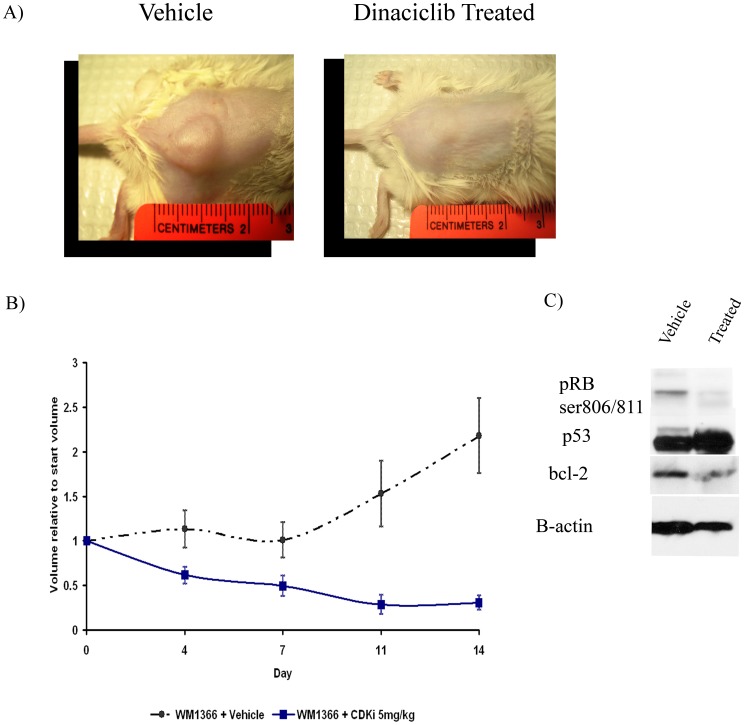
Dinaciclib induces regression of WM1366 melanoma xenografts.A) Photographs of representative vehicle and dinaciclib-treated WM1366 tumors taken after day 14 of treatment. After tumor establishment, mice were dosed twice daily with either vehicle (20% HPBCD) or dinaciclib (5 mg/kg in 20% HPBCD) intraperitoneally for 14 days. B) Growth curves of vehicle or dinaciclib-treated mice. Tumor volumes were measured twice a week and were normalized to the start volumes. Dinaciclib led to tumor regression after 14 days of treatment (p = .0046). C) Dinaciclib treatment led to the downregulation of pRBser807/811, upregulation of p53, and inhibition of Bcl-2 Tumor samples were extracted from SCID mice after 14 days of treatment with dinaciclib or vehicle and were analyzed via western blot. Blots were stripped once and equal protein loading was confirmed by probing the blots for actin expression.